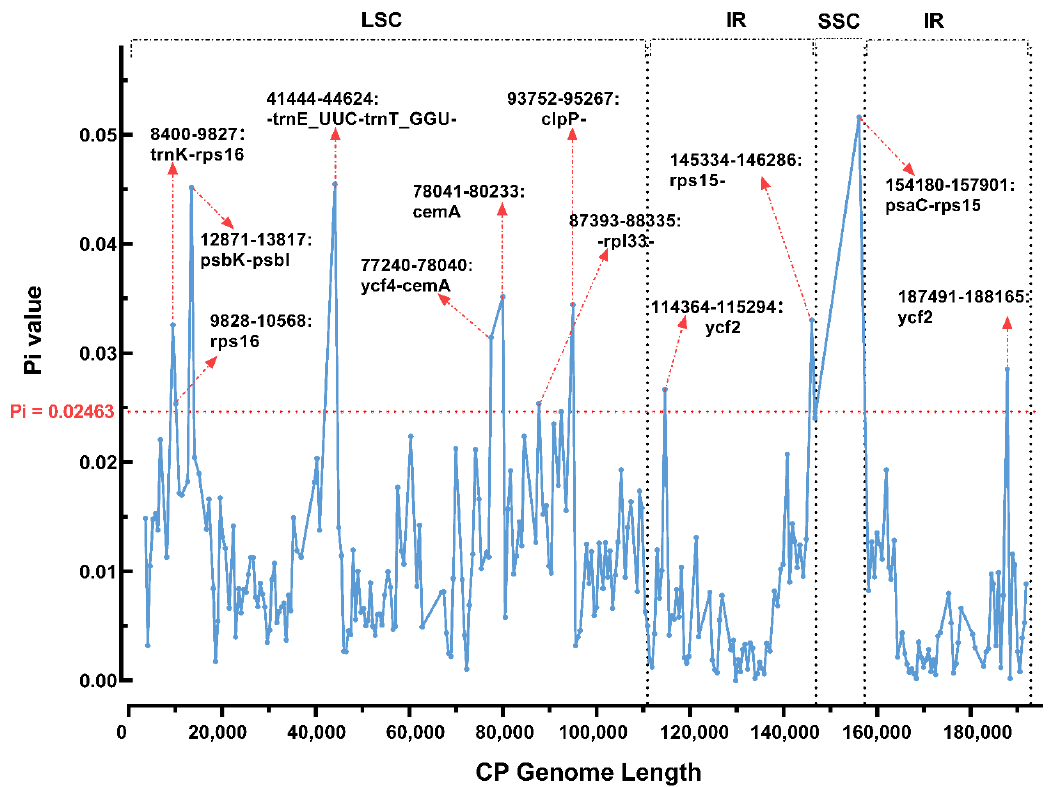
Figure 3. Nucleotide diversity of different regions of Paphiopedilum chloroplast genomes. Red line represents the top 5% threshold of the average nucleotide diversity. The genes located around the hot spots of differentiation are marked with arrows.